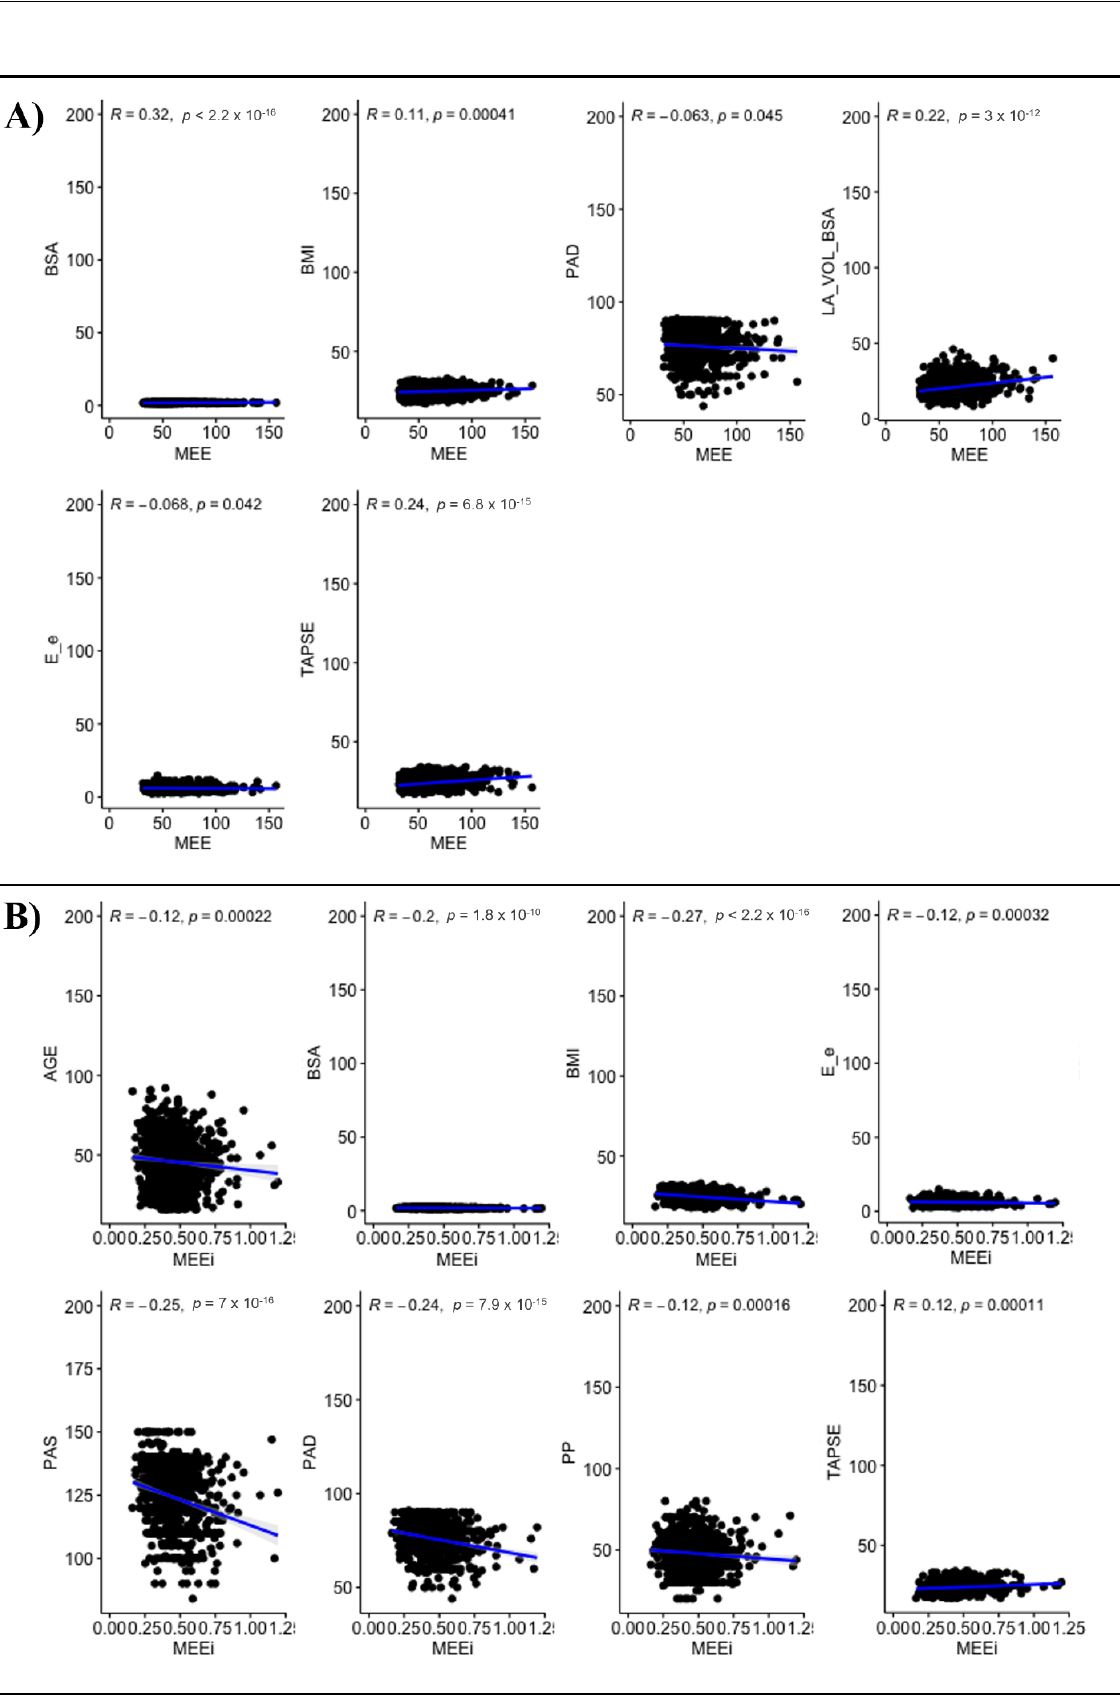
Figure 3. Univariate analysis of MEE ( A ) and MEEi ( B ) values.